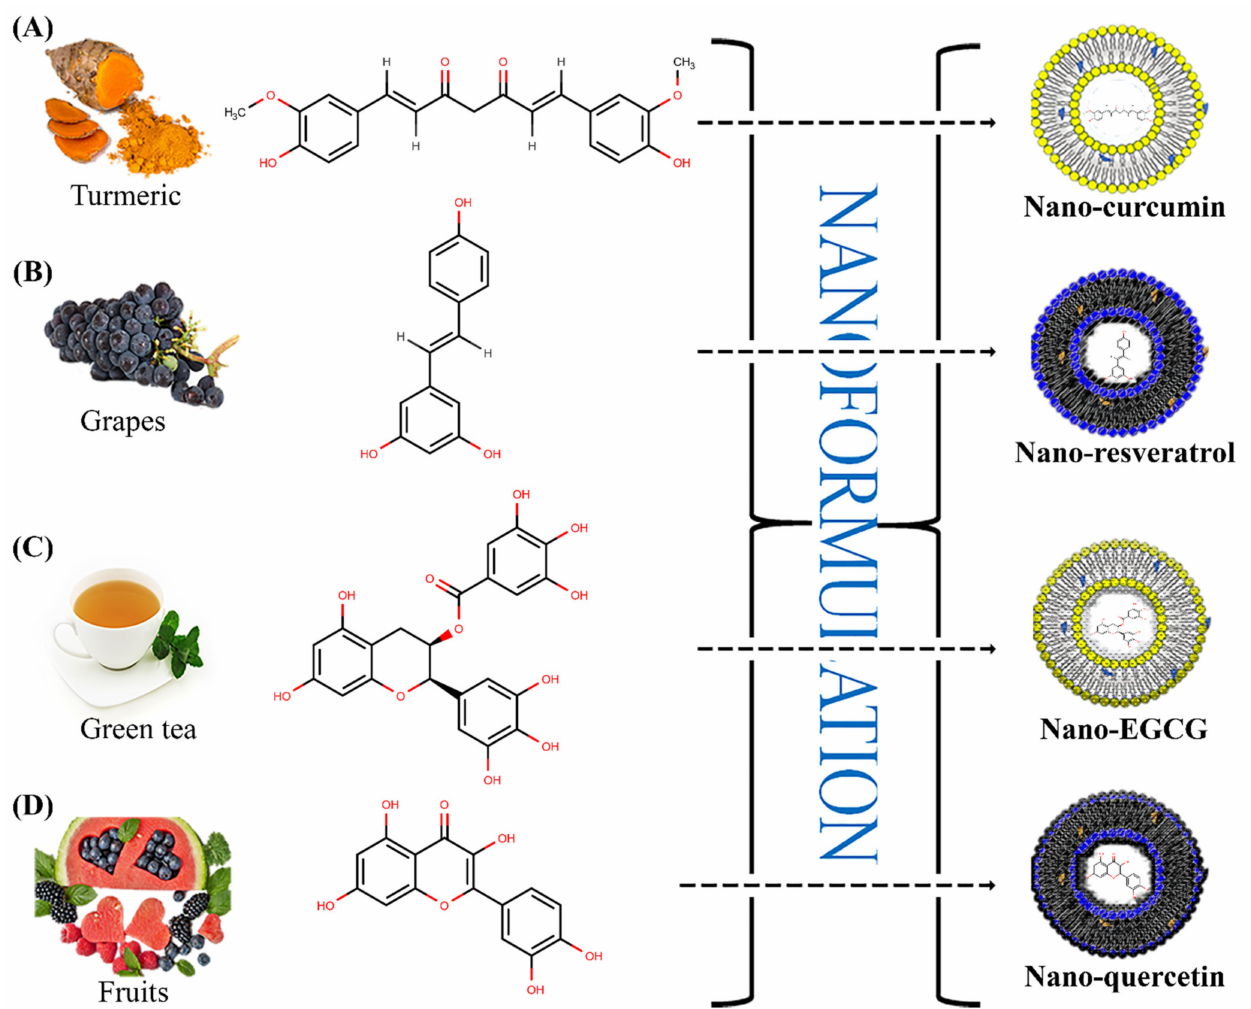
Figure 2. Graphical examples highlighting the concept of nano-phytopolyphenols with selected dietary polyphenols and their common natural sources; namely ( A ) nano-curcumin, ( B ) nano- resveratrol, ( C ) nano-EGCG, and ( D )